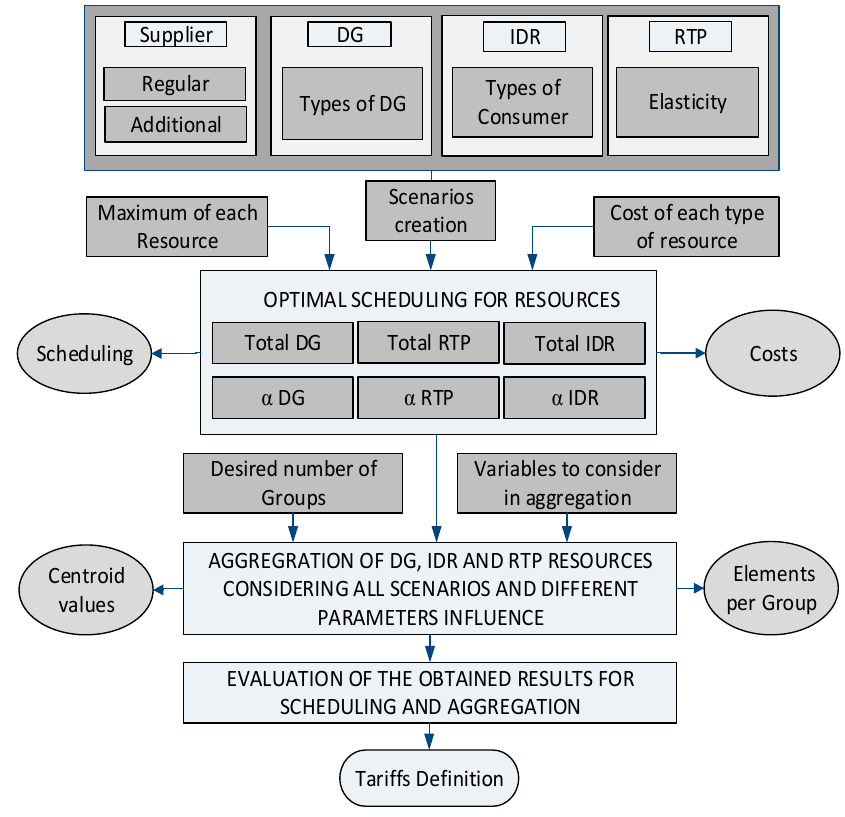
Figure 1. Diagram of the proposed methodology .